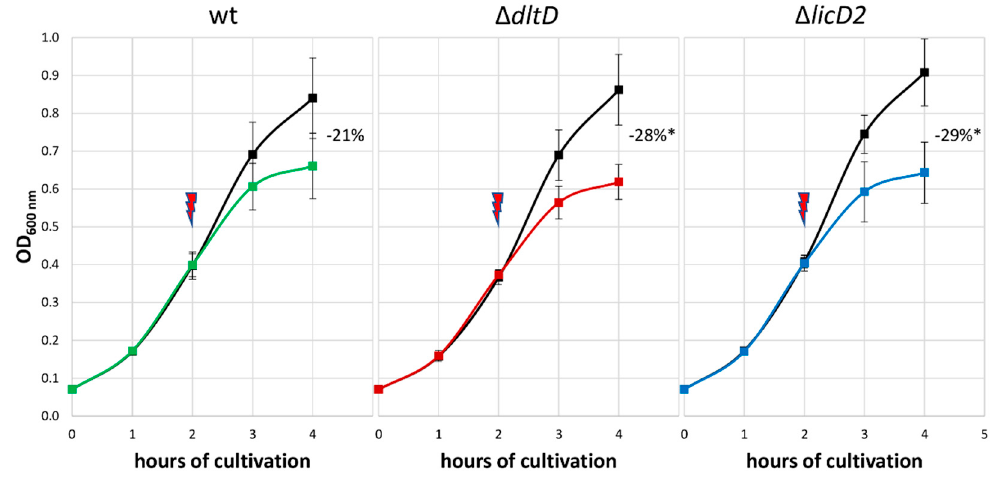
Figure 7. Effect of 2.5 µg/mL LL-37 on the growth of S. pneumoniae D39 wildtype (wt) in comparison to stressed D39 ∆ dltD and D39 ∆ licD2 mutants. The red arrow indicates the application of the stress after two hours of cultivation. The numbers represent the growth inhibition of stressed pneumococci compared to corresponding untreated D39 strains in percentage. * Significant difference between mutant and wt inhibition using one-tailed t-tests assuming unequal variance, p < 0.05. The error bars represent the standard deviation. n = 3.